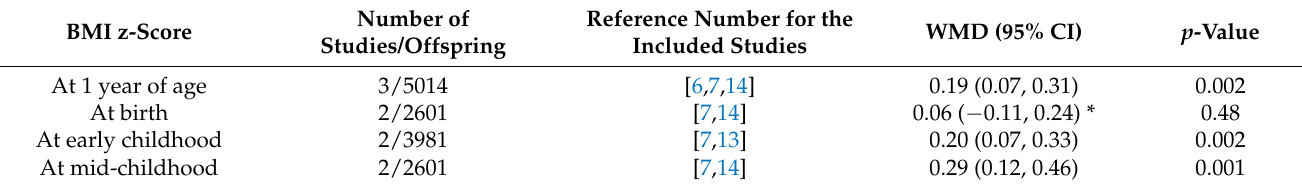
Table 2. Relation between NNS and BMI z-score in